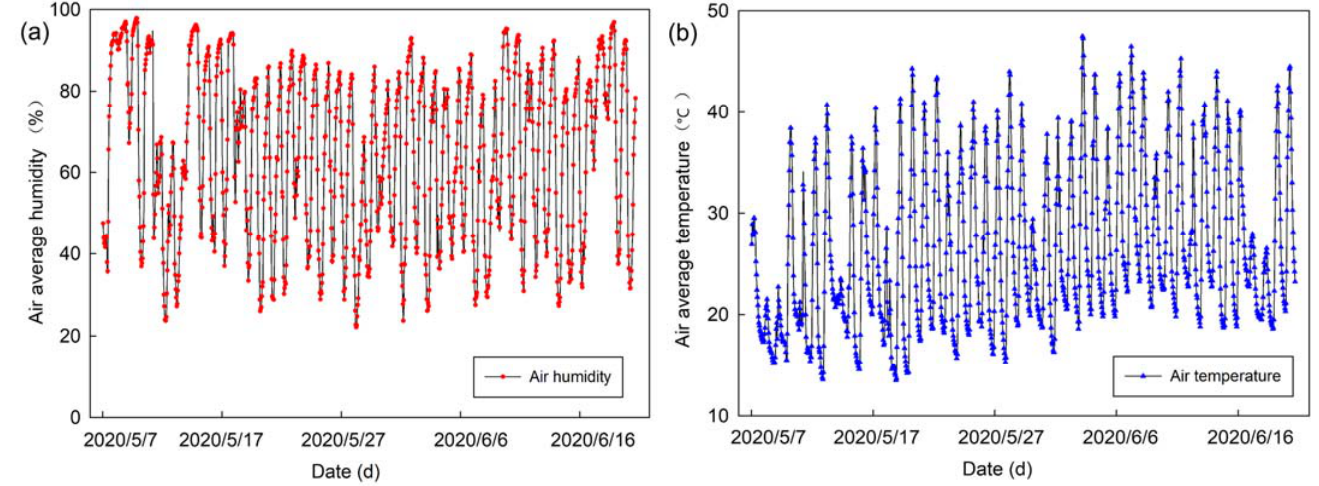
Figure 3. Timing diagram of environment parameters of Greenhouse B. ( a ) Average humidity of the air every hour and ( b ) temperature.